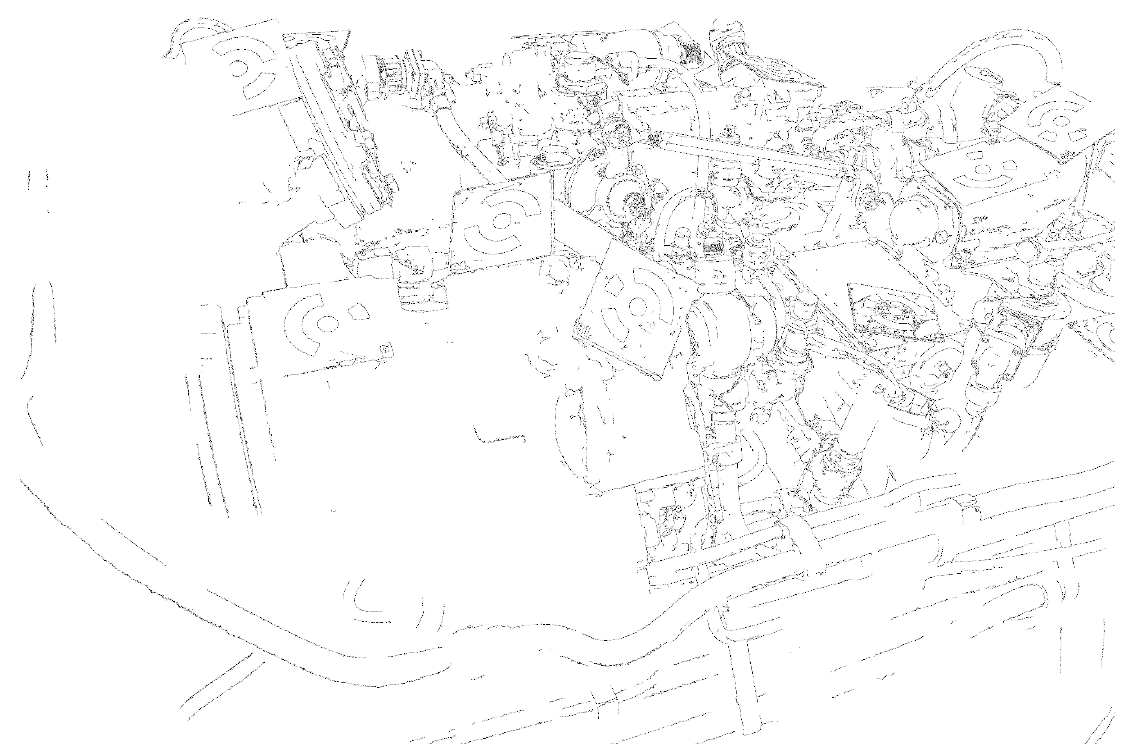
Figure 9. Edge result of the canny method.